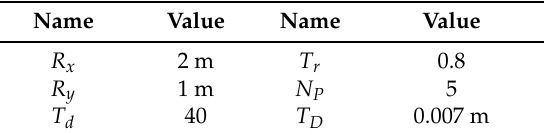
Table 2. Parameters of road marking extraction.